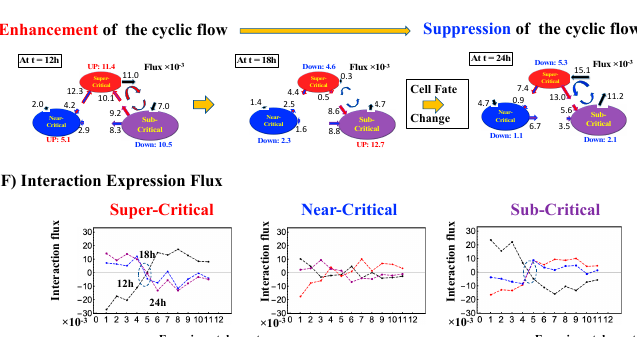
Figure 14. Cell population: mechanism of the cell-fate change through perturbation of the genome engine. ( A ) and ( B ) HRG-stimulated MCF-7 cells; ( C ) and ( D ) atRA-stimulated HL-60 cells, ( E ) and ( F ) DMSO-stimulated HL-60 cells. Before the cell-fate change, the interaction flux dynamics (indicated by the dashed oval: ( B ), ( D ), ( F )) intersect each other. An interaction flux (red: super-critical state; blue: near- critical state; purple: sub-critical state; black: the nuclear environment) is measured from its average value (see details in Section 4.2.4). This intersection marks a non-equilibrium fixed point and the onset of the switch to coherent dynamics on the dominant cyclic flow (genome engine: Figure 12). The interaction flux dynamics show that, on the dominant cycle state flux, ( A ) the switch from suppression to enhancement for MCF-7 cells occurs before the cell-fate change (Figure 4 D ), and ( C ) and ( E ) the switch from enhancement to suppression for HL-60 cells occurs during the cell-fate change. Numerical values based on a 10 − 2 scale for MCF-7 cells and a 10 − 3 scale for HL-60 cells represent interaction flux. Refer to Section 4.1 for further details on experimental time points. Int. J. Mol. Sci. 2020 , 21 , x FOR PEER REVIEW